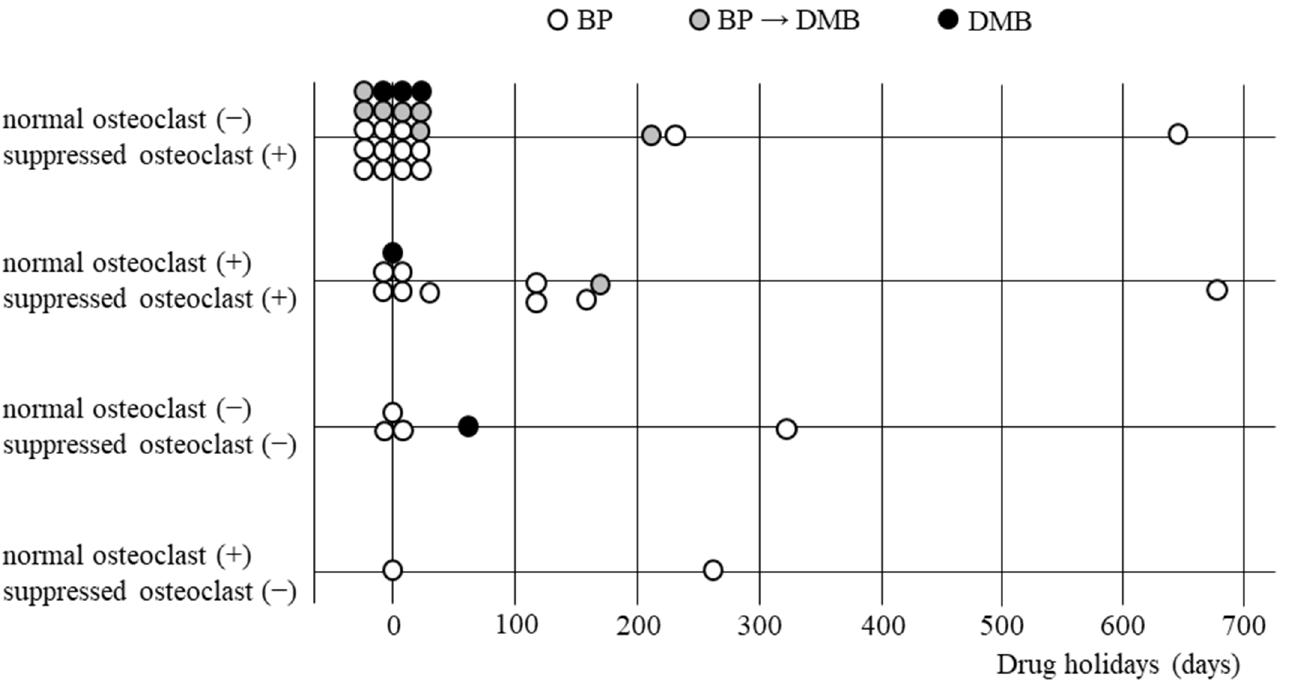
Figure 4. Relationship between drug holidays and osteoclast suppression. BP, bisphosphonate; DMB, denosumab.